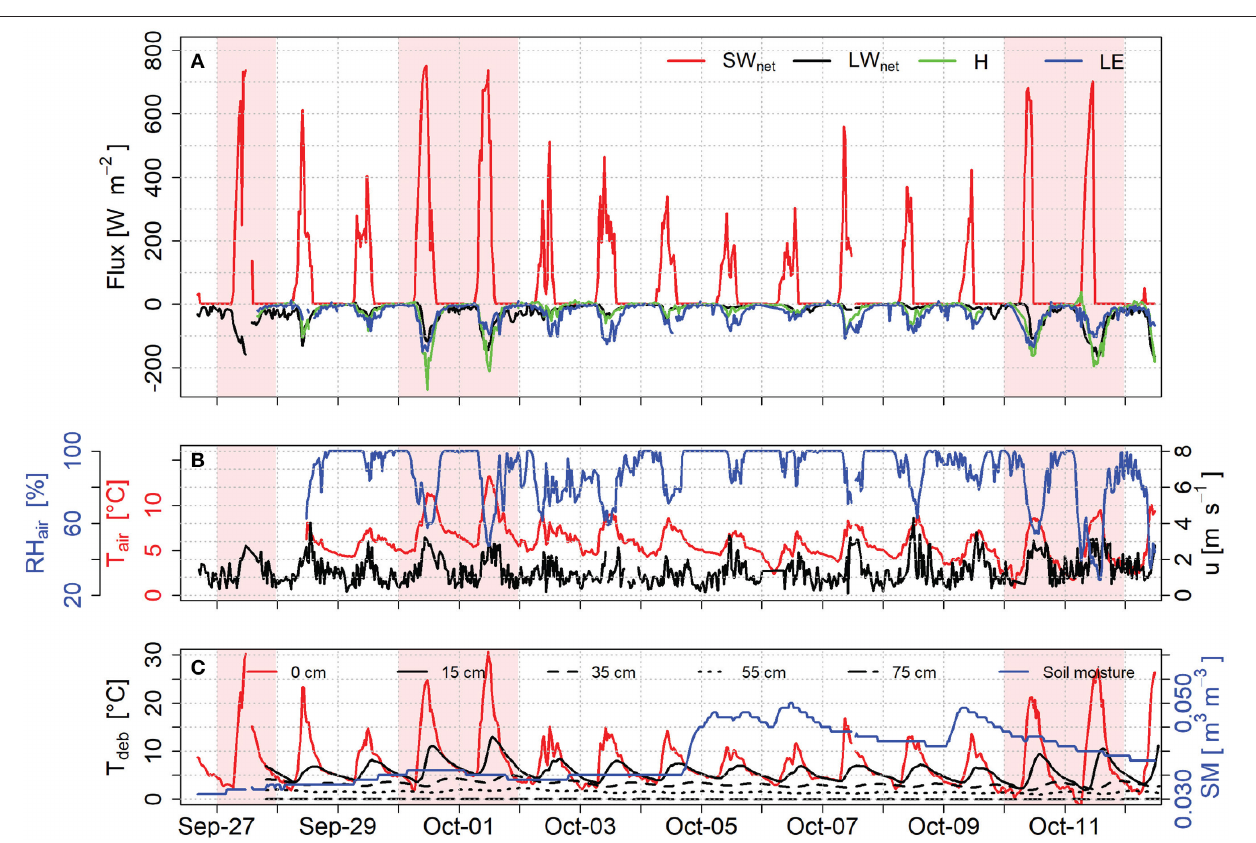
FIGURE 2 | Fluxes and variables measured at the AWS, SW net denoting net shortwave radiation, LW net net longwave radiation, H sensible and LE latent heat flux (A) . Climatic variables, including air temperature (Ta), wind speed (u), and relative humidity (RH) (B) . Debris temperatures and soil moisture (SM) (C) . The shaded time periods mark days we define as clear sky days, the others are overcast.